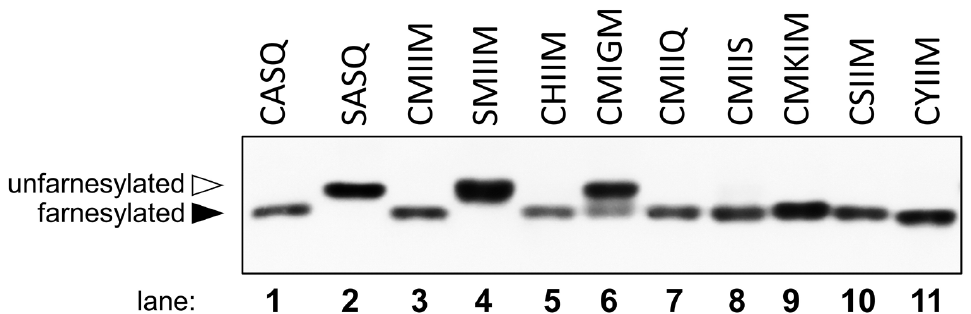
Figure 6. Mobility shift analysis of Ydj1p-CaaaX variants identified from peptide libraries. Whole- cell lysates prepared from yeast expressing the indicated Ydj1p-CaaaX variant were evaluated by SDS-PAGE and anti-Ydj1p immunoblot. The indicated Ydj1p variants were expressed in yWS2544 (ydj1::KANR) to eliminate any contribution from naturally encoded Ydj1p. Farnesylated Ydj1p (CASQ) exhibits a smaller apparent molecular mass relative to unmodified Ydj1p (SASQ). Farnesyla- tion profiles for the indicated Ydj1p-CaaaX variants were determined across multiple biological and technical replicates, from which the percent of farnesylated species relative to the total signal for a sample was determined (see Figures S13 - S14 and Table S4).